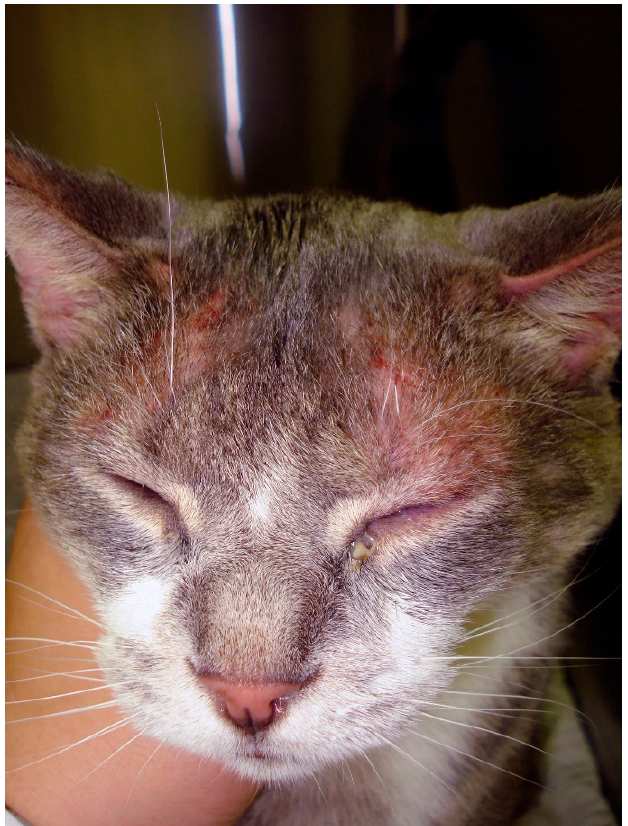
Figure 3. Severe pruritis and facial dermatitis in cat diagnosed with feline atopic skin syndrome. As facial pruritus can be triggered by many diseases, it is important to rule out mites, dermatophytes, and fleas before considering feline atopic skin syndrome as a clinical diagnosis.